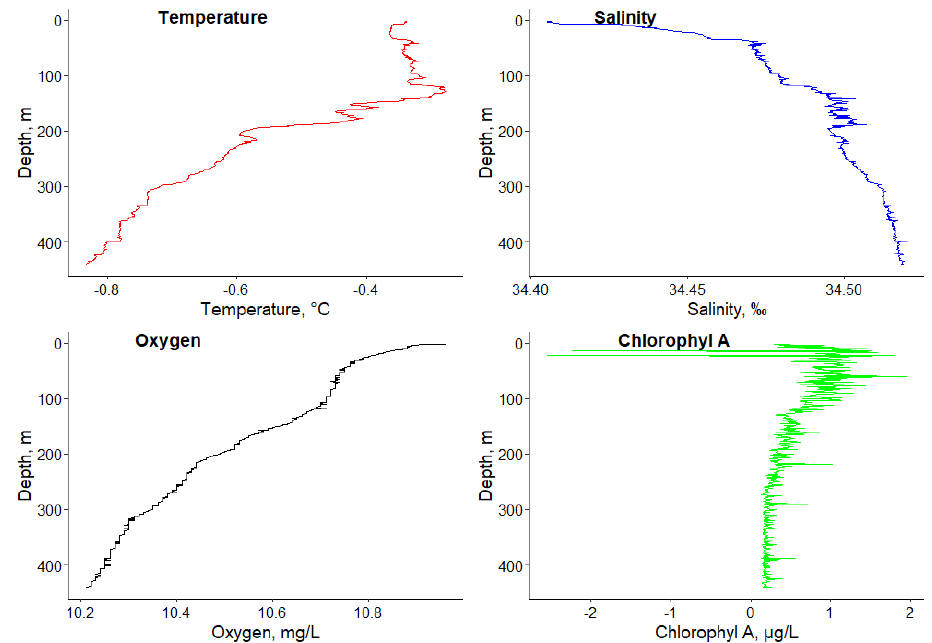
Figure 1. Vertical profiles of temperature, salinity, dissolved oxygen, and chlorophyl A at the depth gradient (0 – 440 m) in the sampling area of Pleuragramma antarcticum (the Antarctic Sound, Atlantic sector of Antarctic).